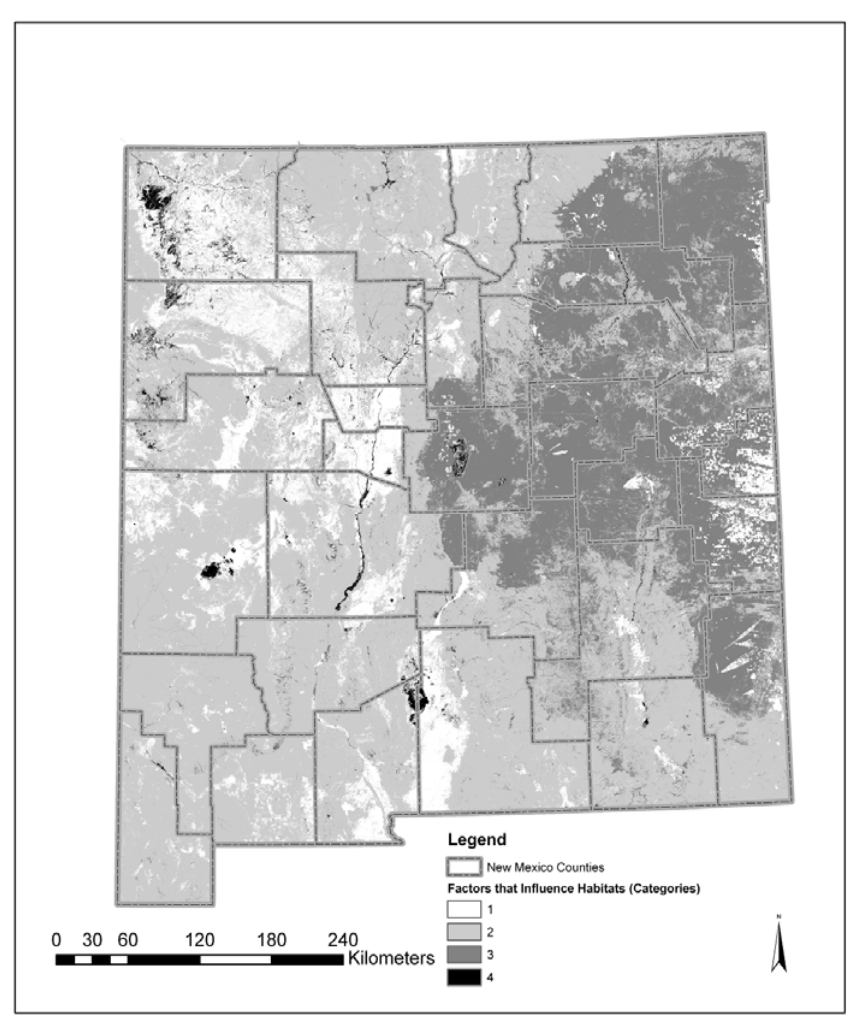
Figure 5. Magnitude scores of factors that influence habitats associated with terrestrial and aquatic land cover types. This spatial representation is designed to enhance understanding of geographic areas where multiple effects of potential factors may influence some habitats more than